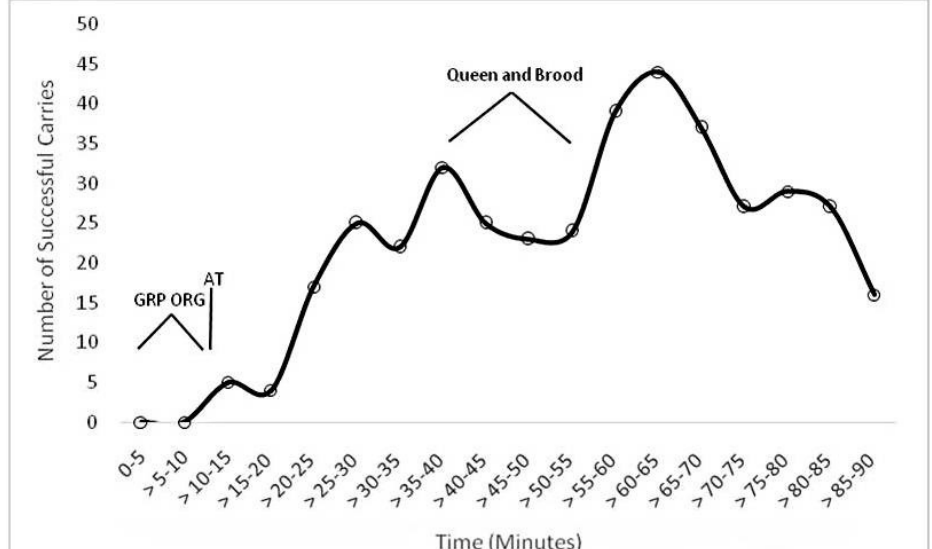
Fig 2 . Pooled total number of successful carries by B. chinensis workers occurring at 5-minute intervals during treatment nest emigration trials (n = 10 colonies). Worker ants organized into groups (GRP ORG) FROM 0-13 min. Adult transport (AT) began at the 12 min and continued for 90 min. Queens and brood were transported from 35-55 min. The number of successful transports performed by B. chinensis workers decreased during queen and brood movement. Transport activities increased after the queen and brood were moved to the new